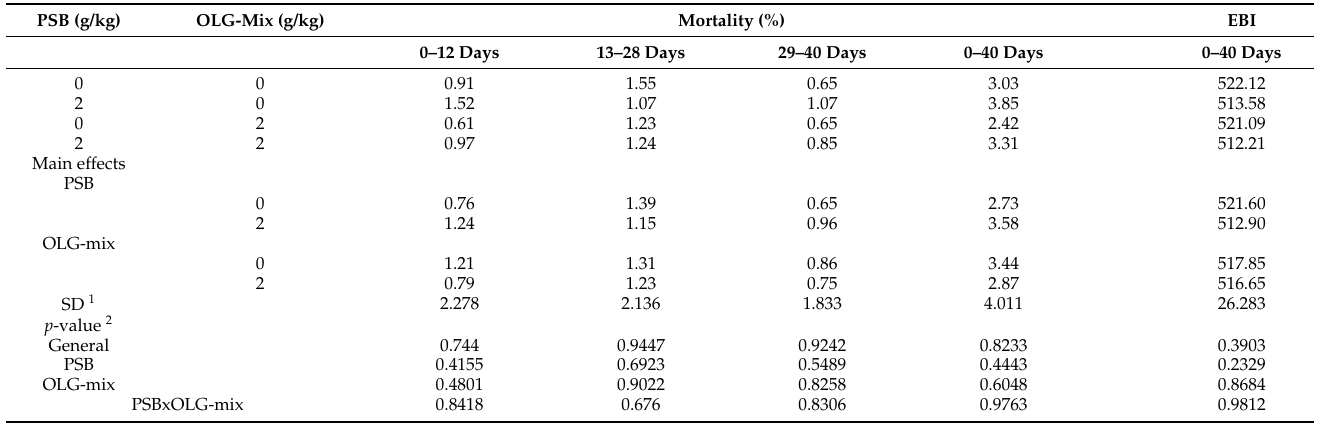
Table 3. Effect of protected sodium butyrate (PSB) olive leaf and grape-based by-product (OLG-mix), and their interaction on mortality (%) and European Broiler Index (EBI).